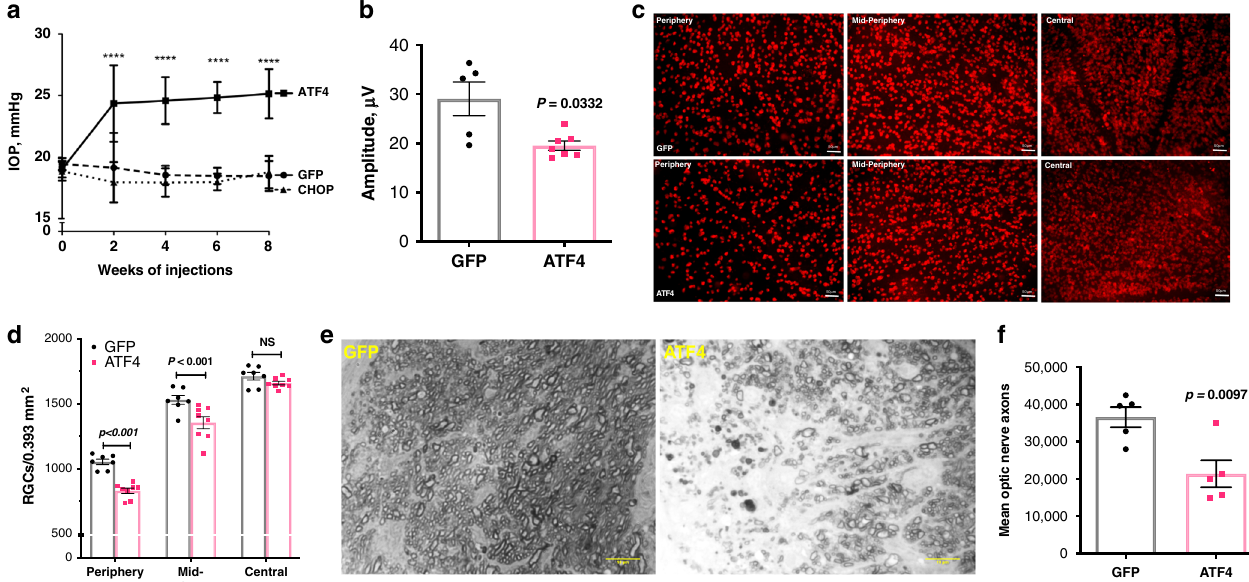
Fig. 3 Lentiviral expression of ATF4 but not CHOP induces glaucoma in mice. a Night-time IOP measurements in mice injected intravitreally with lentiviral particles expressing GFP (control), ATF4, and CHOP (2 × 10 6 TU/eye). A signi fi cant IOP elevation was observed in ATF4-injected mice compared to GFP or CHOP-injected mice ( n = 7 in GFP group, n = 8 in ATF4 and CHOP groups; data are presented as mean ± SEM, two-way ANOVA, Tukey ’ s multiple comparison test, **** P < 0.0001). b RGC functional loss in ATF4-injected mice. A decrease in pattern ERG amplitudes was observed in 8 weeks ATF4-injected mice ( n = 7) compared to GFP-injected mice ( n = 5; data are presented as mean ± SEM, two-tailed unpaired t -test. c Loss of RGCs in 10 weeks ATF4-injected mice. Representative images showing peripheral, mid-peripheral, and central regions of whole mount retinas stained with RBPMS (RGC marker) in GFP ( n = 7) and ATF4 ( n = 8) injected groups. d RGC counts per 0.393 mm 2 of total retina in peripheral, mid-peripheral, and central regions of ATF4 and GFP-injected mice demonstrated signi fi cant loss of RGCs in periphery and mid-periphery of ATF4-injected retinas. Scale bar is 50 µ m. Data are presented as mean ± SEM, one-way ANOVA; n = 7 for GFP and n = 8 for ATF4. e Representative images of optic nerve sections stained with PPD showing loss of axons in 10 weeks ATF4-injected mice. Scale bar is 10 µ m ( n = 5 in GFP and n = 5 in ATF4 injected mice). f PPD stained optic nerve axons were counted and total number of axons per optic nerve were shown graphically in GFP ( n = 5) vs. ATF4 ( n = 5) injected mice groups (data are presented as mean ± SEM, two-tailed unpaired t